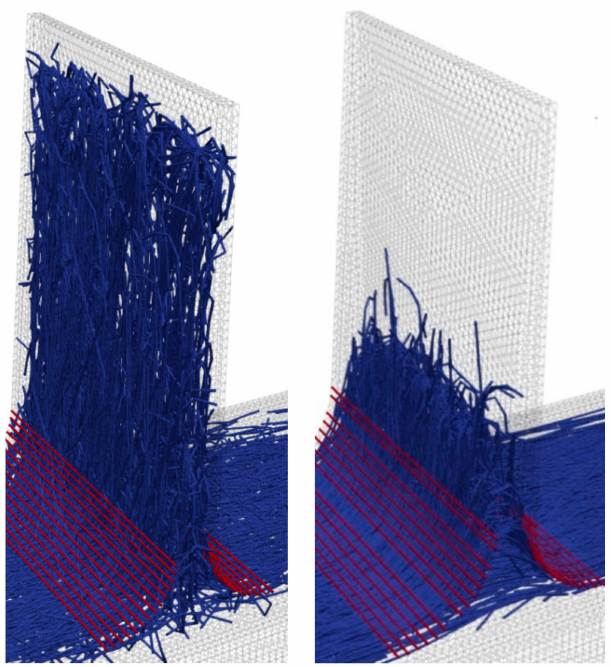
Figure 8. Ten-millimeter fibers’ random orientation ( left ) vs. 20 mm fibers with cross rib orientation ( right ) after filling completed. Fiber diameter is exaggerated for visibility purposes.